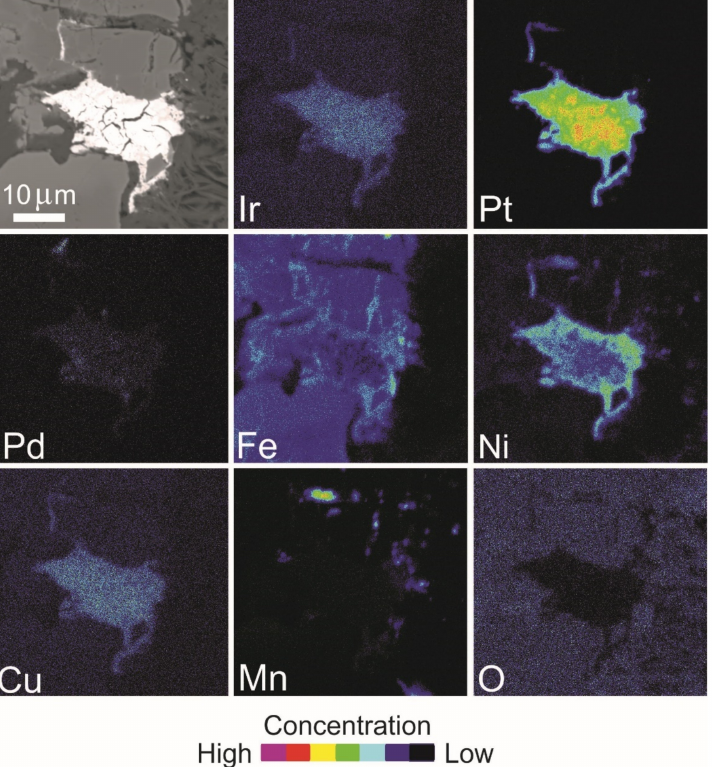
Figure 19. BSE image and X-ray elemental distribution maps of Ir, Pt, Pd, Fe, Ni, Cu, Mn and O in the Pt alloy of Figure 18A.